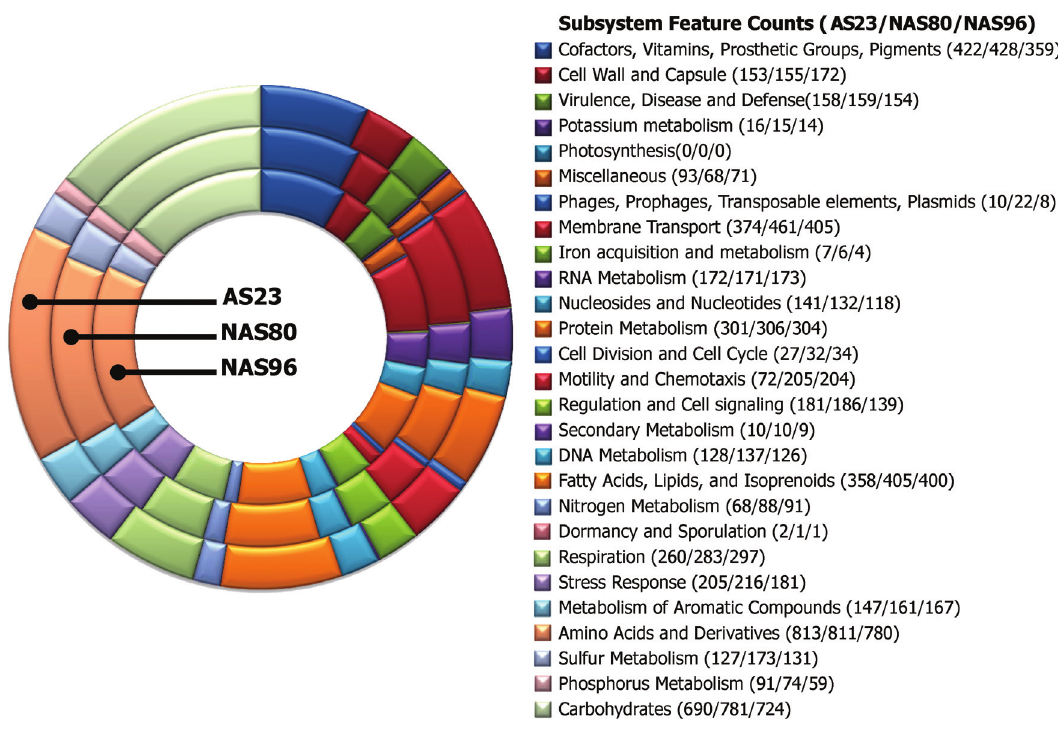
Figure 1 - Subsystem category distribution and coverage of genes of the three Bradyrhizobium sp. isolates AS23, NAS80, and NAS96. In parenthesis are the number of genes in each subsystem for AS23, NAS80, and NAS96, respectively.